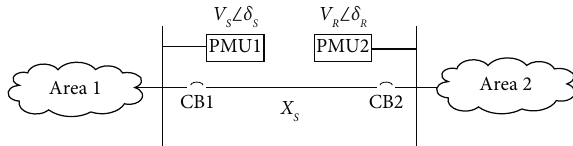
Figure 4: PMUs on buses on both ends of the tie line.